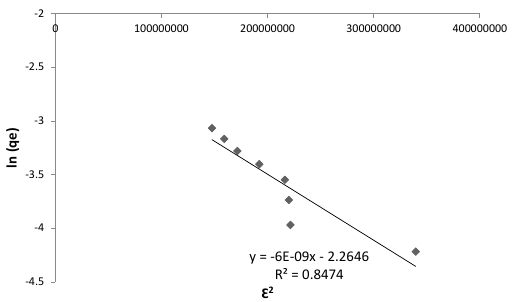
Fig. 13. D-R adsorption isotherm of Amido Black 10B onto Polyaniline nano-adsorbent